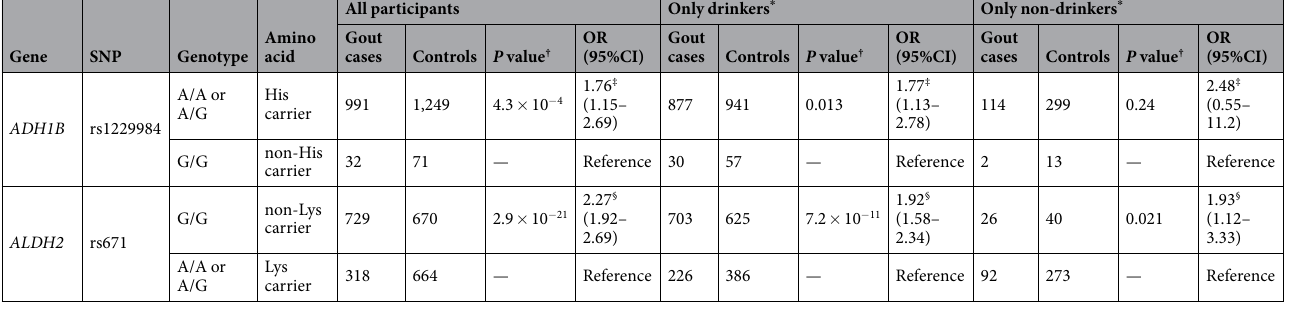
Table 3. Effect of ADH1B and ALDH2 genotypes and alcohol consumption on gout susceptibility. Abbreviations: OR = odds ratio; CI = confidence interval; His = histidine; Lys = lysine. * Participants who consumed alcohol less than once a month were classified as non-drinkers. † The P values were calculated using logistic regression analysis. ‡ For rs1229984 (His48Arg), A/A (His/His) or A/G (His/Arg) genotype (His carrier, high tolerance for alcohol) is a risk, so the “His carrier” vs. “non-His carrier” model was used for the analysis of rs1229984. § For rs671 (Glu504Lys), G/G (Glu/Glu) genotype (non-Lys carrier, high tolerance for alcohol) is a risk, so the “non-Lys carrier” vs. “Lys carrier” model was used for rs671.